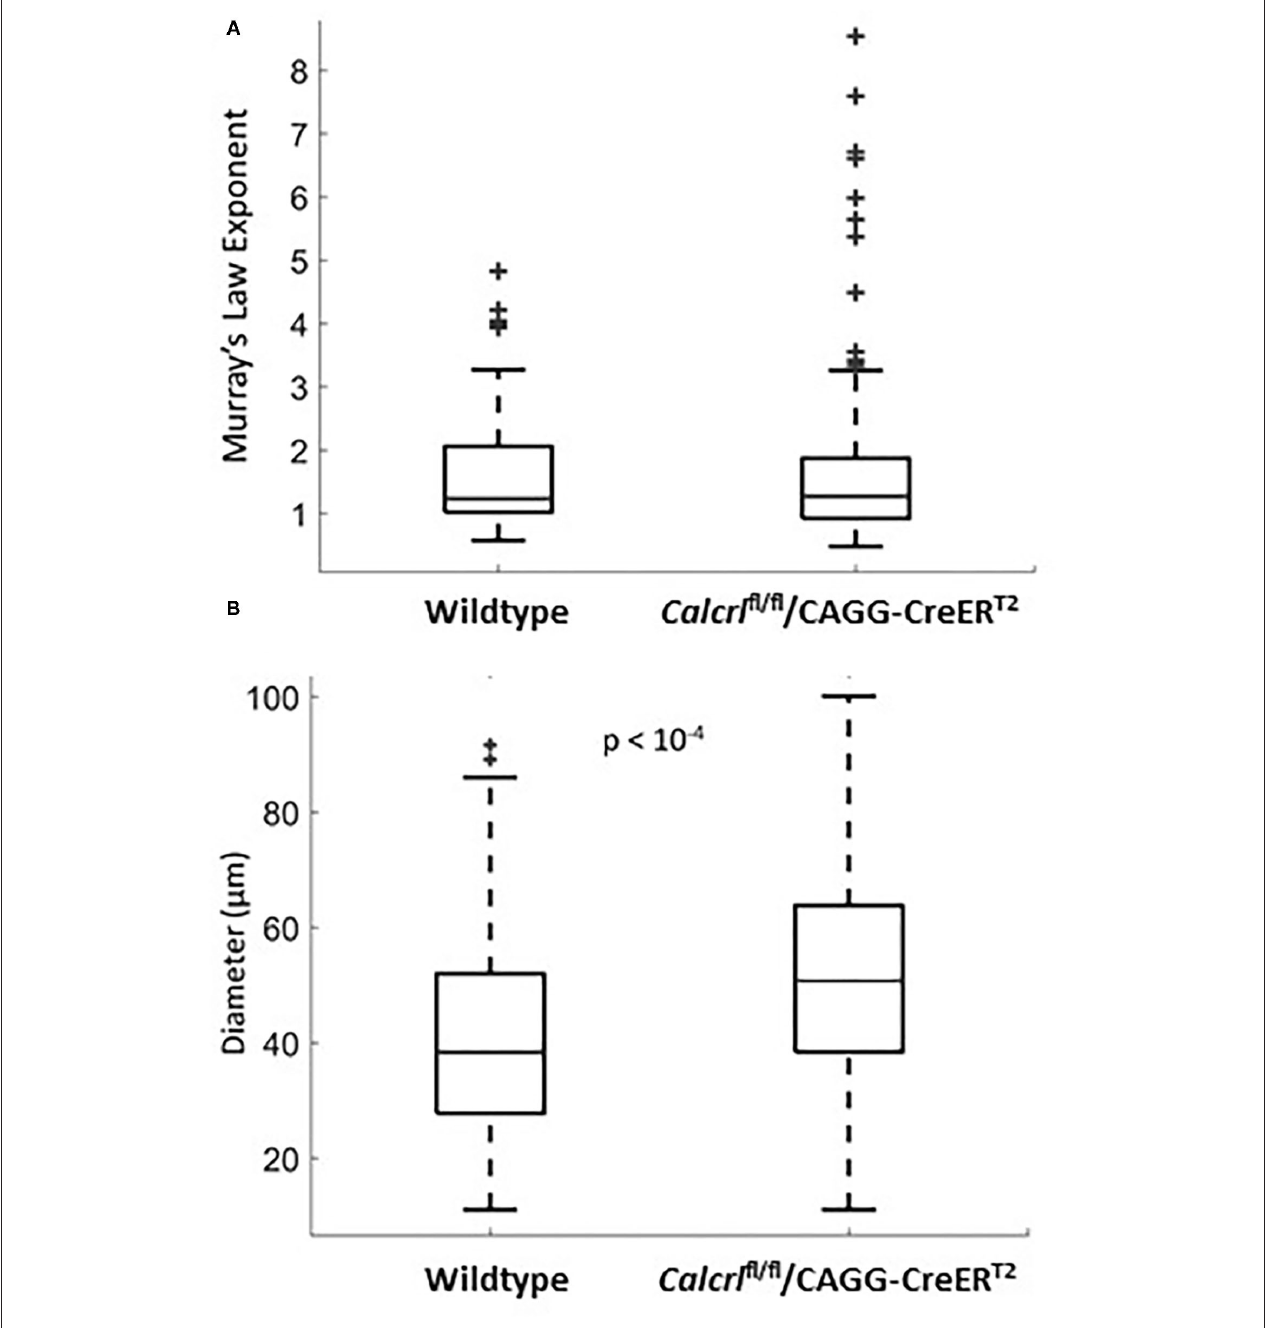
FIGURE 2 | (A) Murray’s Law exponent distribution for dermal lymphatic capillaries in wild type ( n = 47 measurements, n = 5 mice) and Calcrl − / − knockout ( n = 131 measurements, n = 8 mice). All measurements were taken in adult ear tissue. Note the extent of the spread in the Calcrl − / − distribution. (B) Diameter distribution for dermal lymphatic capillaries in wild type ( n = 115 measurements, n = 8 mice) and Calcrl − / − knockout ( n = 143 measurements, n = 9 mice) adult